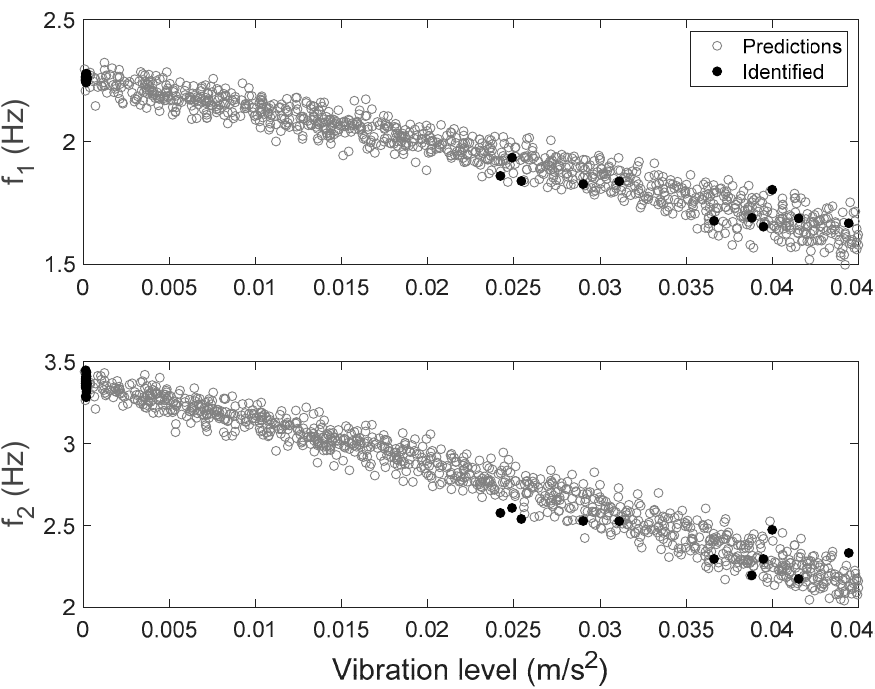
Figure 15. Natural frequencies predictions with their identified counterparts [56].